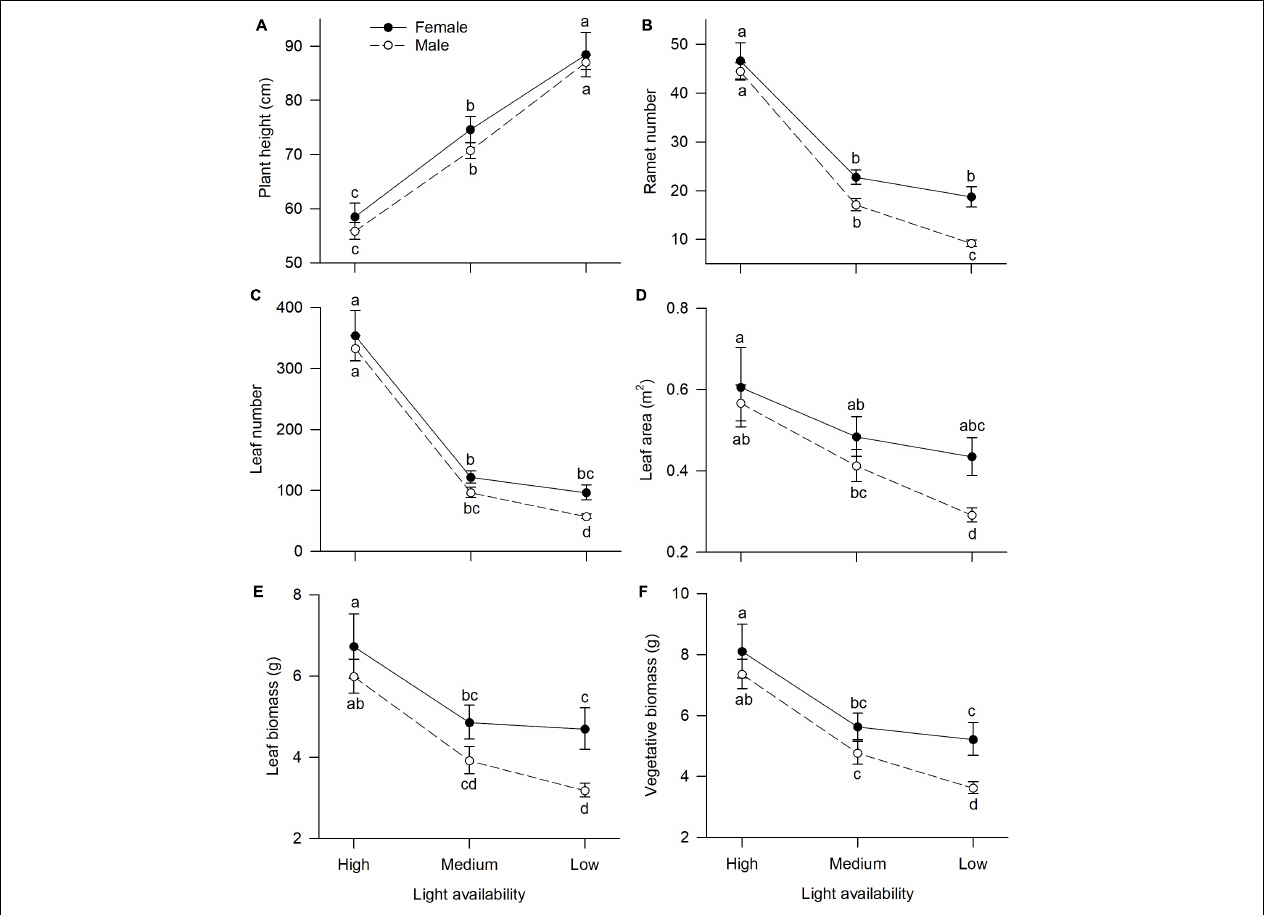
FIGURE 1 | Effects of light availability on allocation to vegetative tissues for both males and females of V. spinulosa at reproductive maturity: (A) plant height, (B) ramet number, (C) leaf number, (D) leaf area, (E) leaf biomass, and (F) vegetative biomass. Letters denote significant difference ( P < 0.05), using Tukey HSD comparisons. Error bars show ± SE. Curves are usually used to display differences between sexes under different environmental conditions (Harris and Pannell, 2008; Hesse and Pannell,